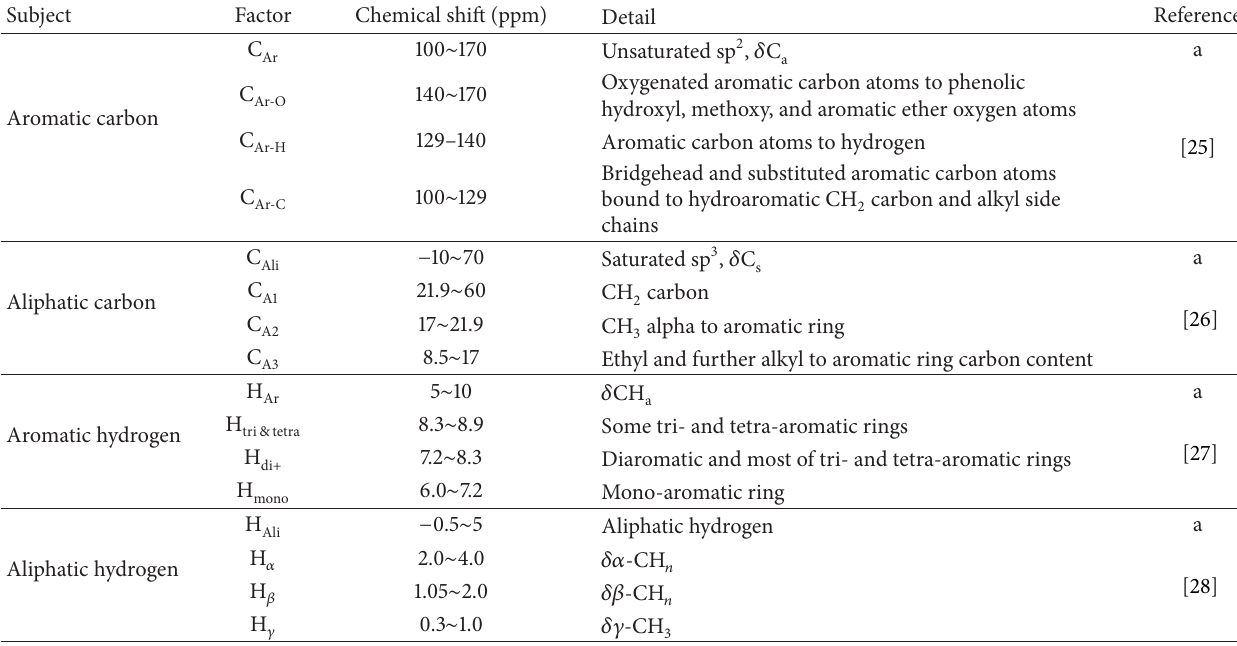
Table 3: Carbon and hydrogen types obtained by 13 C-NMR and 1 H-NMR